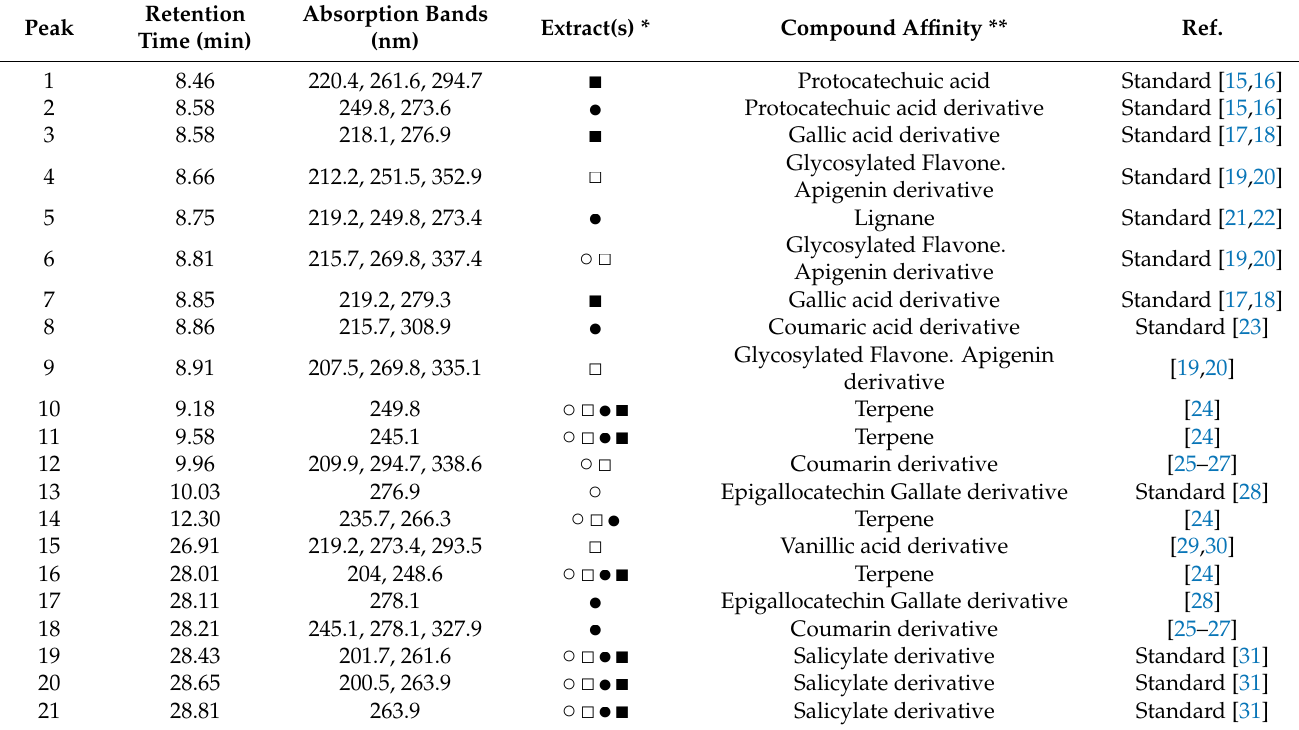
* Extracts: Bark extracts, ● ( Ij-BD ), ■ ( Ij-BHac ); Leaf extracts, ○ ( Ij-LD ), □ ( Ij-LHac ). ** Compounds were suggested by a preliminary comparison of retention time ( t R ) and UV-Vis bands with stand- ards and literature data. ards and literature data.